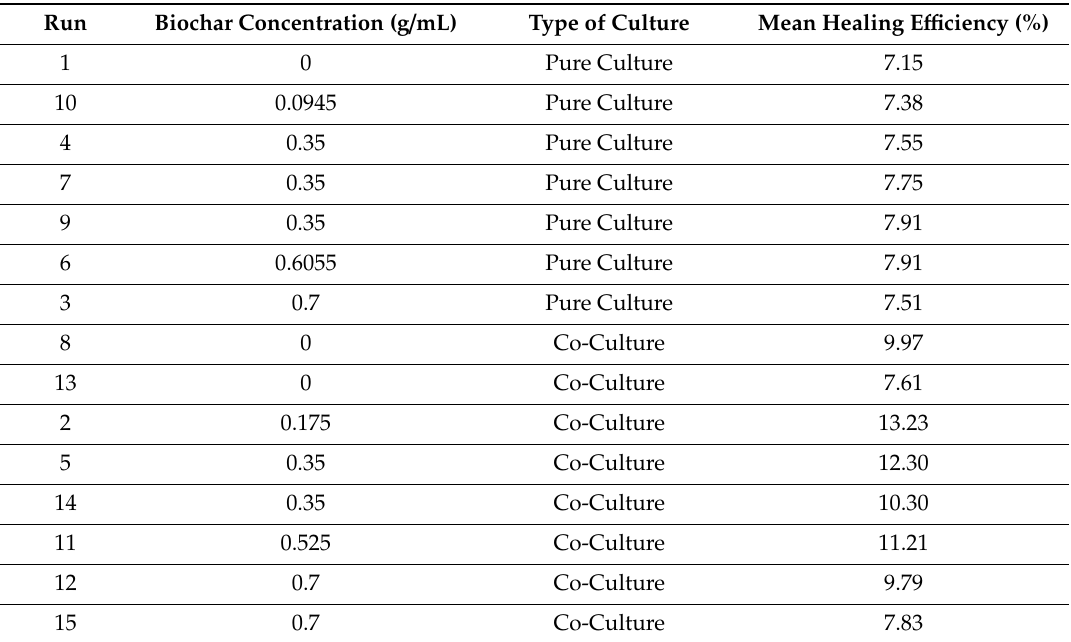
Table 3. Healing e ffi ciencies of the bacteria-containing geopolymers based on UPV measurements. Run Biochar Concentration (g /